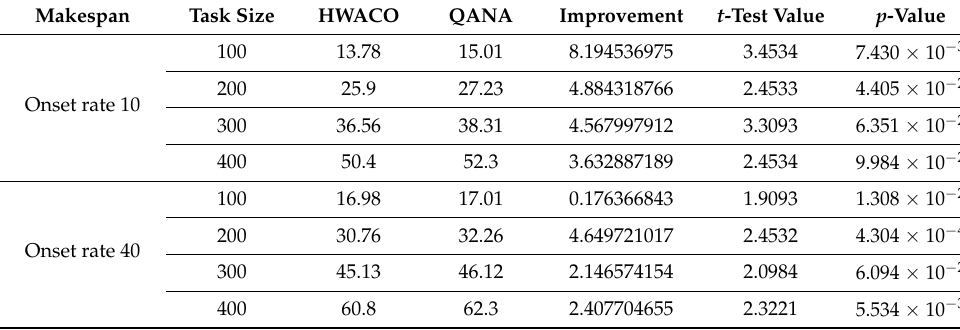
Table 5. t -Test for makespan between HWACO and MFT-BPSO.